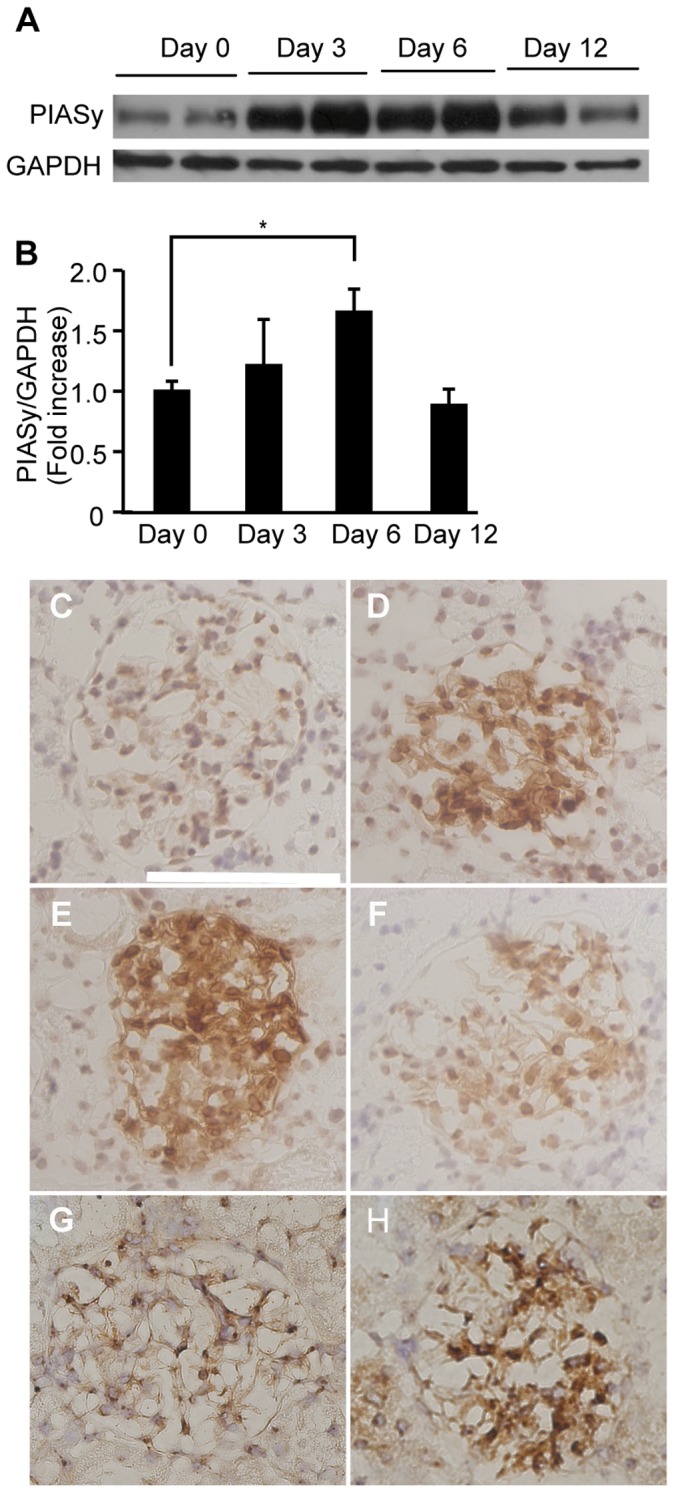
Up-regulation of PIASy and SUMO-1 in Thy1 glomerulonephritis.(A) Expression of PIASy protein in glomeruli from Thy1 GN. Glomerular lysates were subjected to Western blot analyses with an anti-PIASy antibody. Representative picture is shown. PIASy was significantly upregulated at day3 and 6 in the course of Thy1 GN (n = 4; P<0.05) (B) Optical densitometry of PIASy in Western blotting. The data are expressed as mean ± SD (n = 4 in each group). (C, D, E and F) Immunohistological analysis of PIASy in Thy1 glomerulonephritis at day 0 (C), day 3 (D), day 6 (E) and day 12 (F). Note that nuclear staining of PIASy was seen in the glomeruli at day 3 and 6. (G and H) Immunohistological analysis of SUMO-1 in Thy1 glomerulonephritis at day 0 (G), and day 6 (H). Sections were counterstained with hematoxylin solution. White scale bar = 100 µm. Original magnifications, ×400.